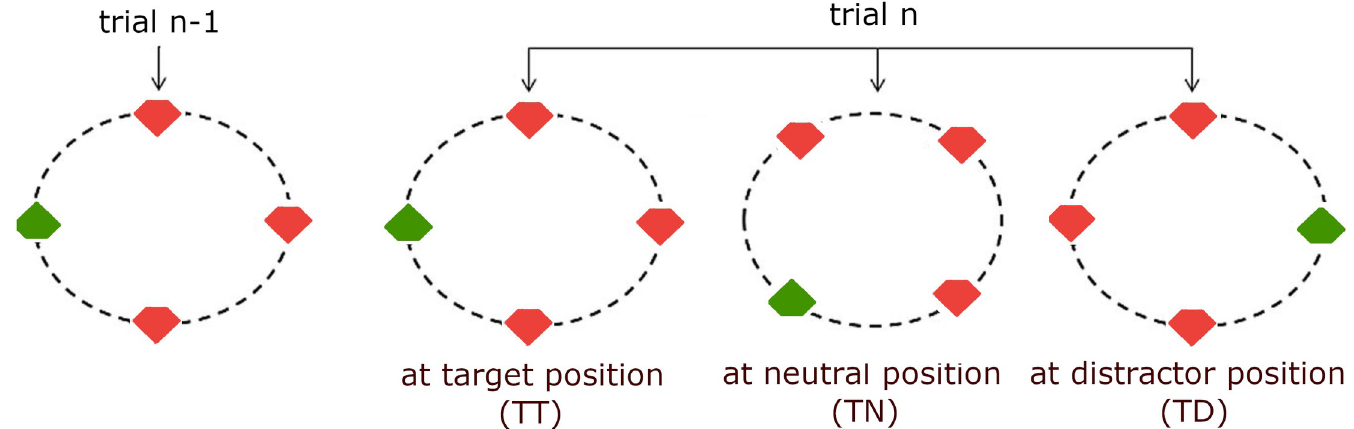
Fig 2. Illustration of the stimulus. Illustration of the search display and the positional inter-trial transitions. The circles were not part of the actual stimulus, but are only shown to illustrate how the items were positioned on a circle. On each trial, four out of eight possible locations were occupied by the search items, allowing the items to form either a square or a diamond